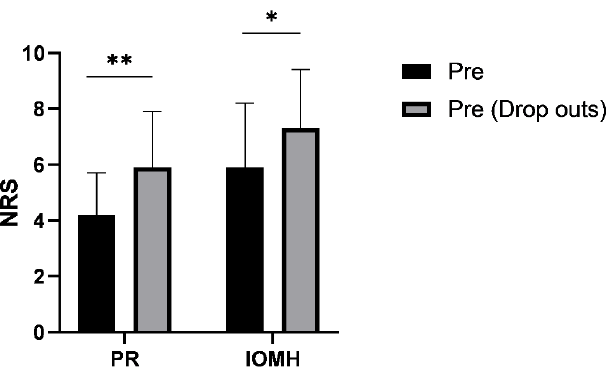
Figure 6. Comparison of PR and IOMH (pre, before the program) between patients who finished the program and those who dropped out. (* p < 0.05, ** p < 0.01)